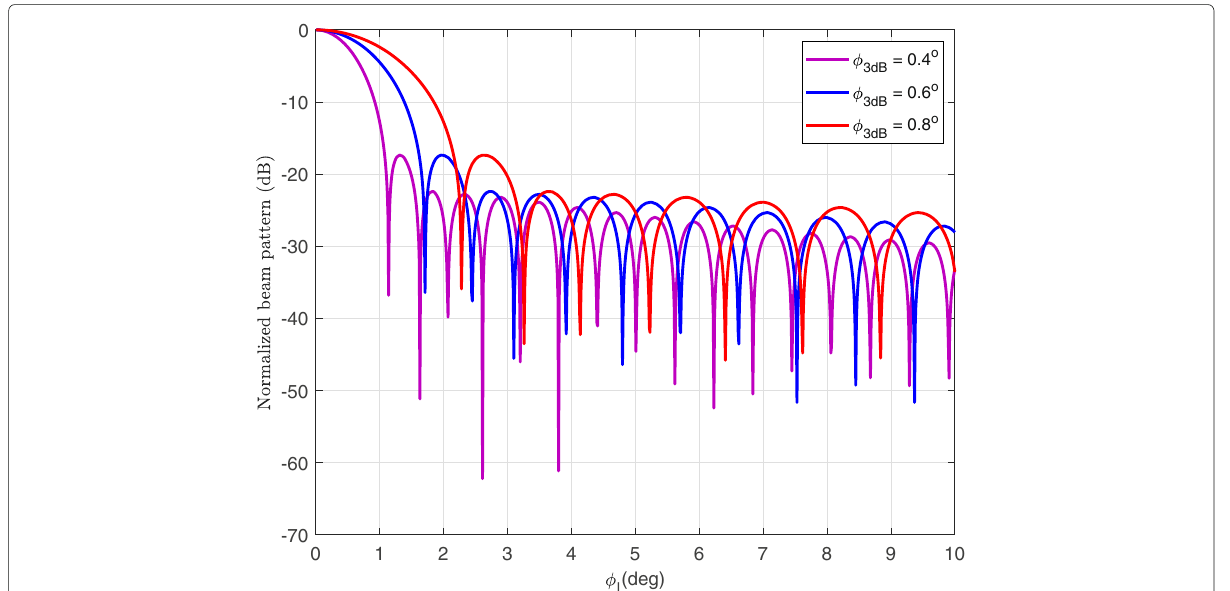
Fig. 2 Normalized beam pattern with different 3 dB angles. This figure presents normalized beam pattern when the 3 dB angles are 0.4 ◦ , 0.6 ◦ , and 0.8 ◦ ,